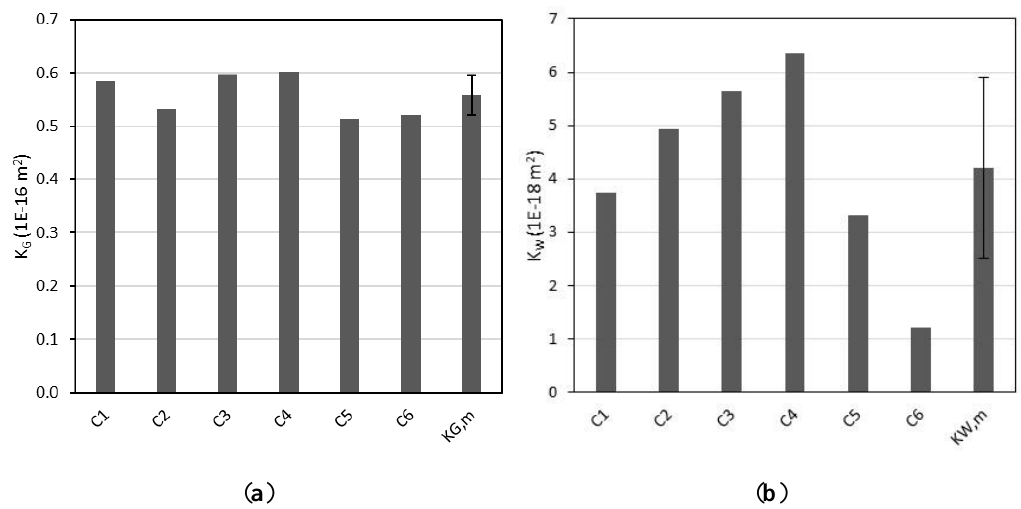
Figure 20. ( a ) results obtained for air permeability coefficient, K G , for EAFS8D1 mixture; ( b ) results obtained for water permeability coefficient, K W , for EAFS8D1 mixture. Table 21. Quality class of concrete as a function of its water permeability coefficient.